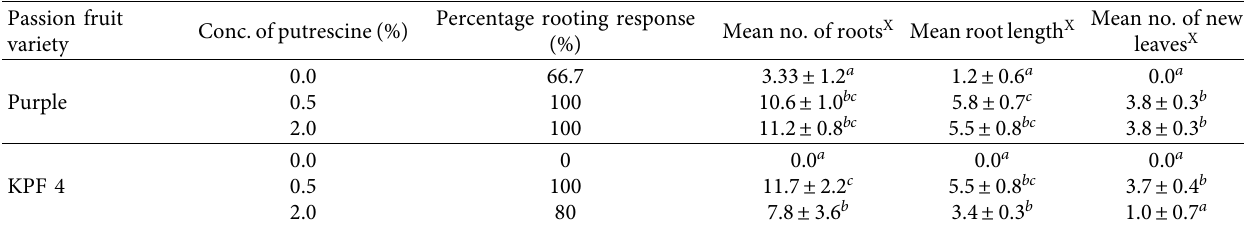
Table 3: Effect of putrescine on rooting of nodal explants of KPF 4 and purple passion fruit varieties. Passion fruit Conc. of putrescine (%) variety